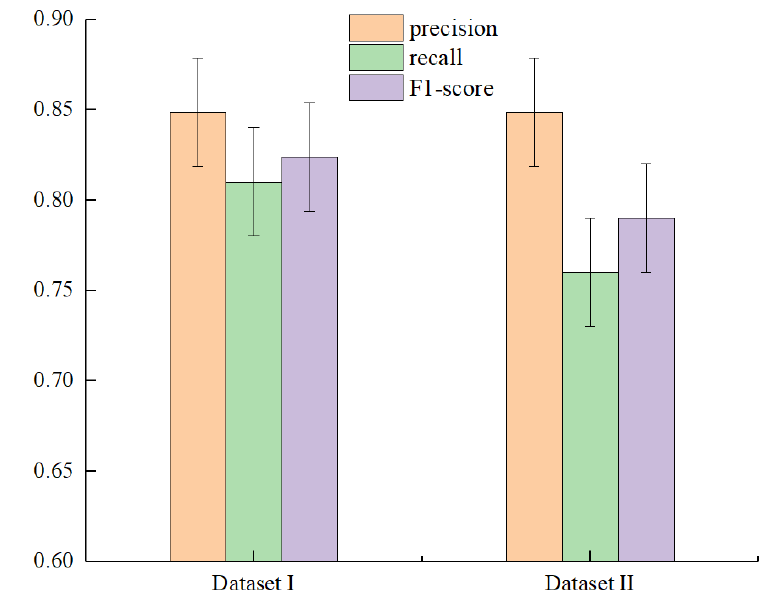
Figure 9. Evaluation results of rebar detection.